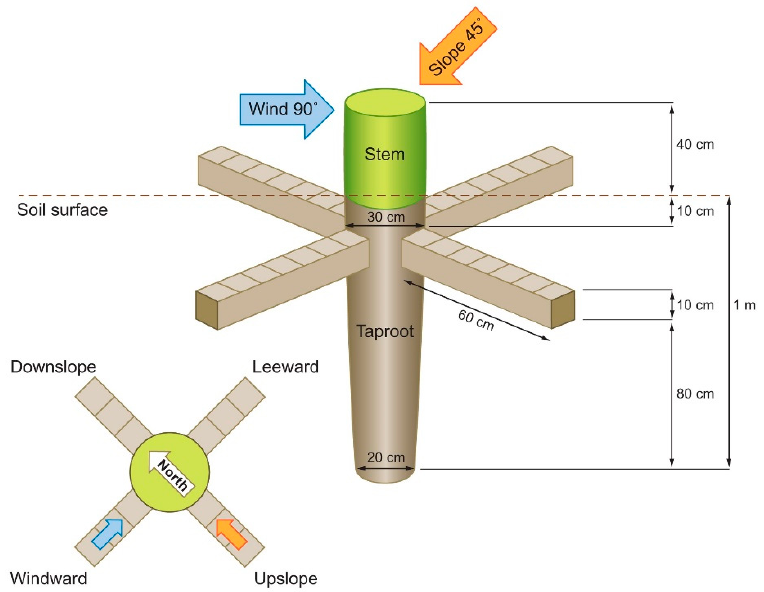
Figure 3. Model representing the distribution of mechanical forces affecting a root system formed by the taproot axis and four lateral roots branching from the taproot and elongating in the four cardinal directions.